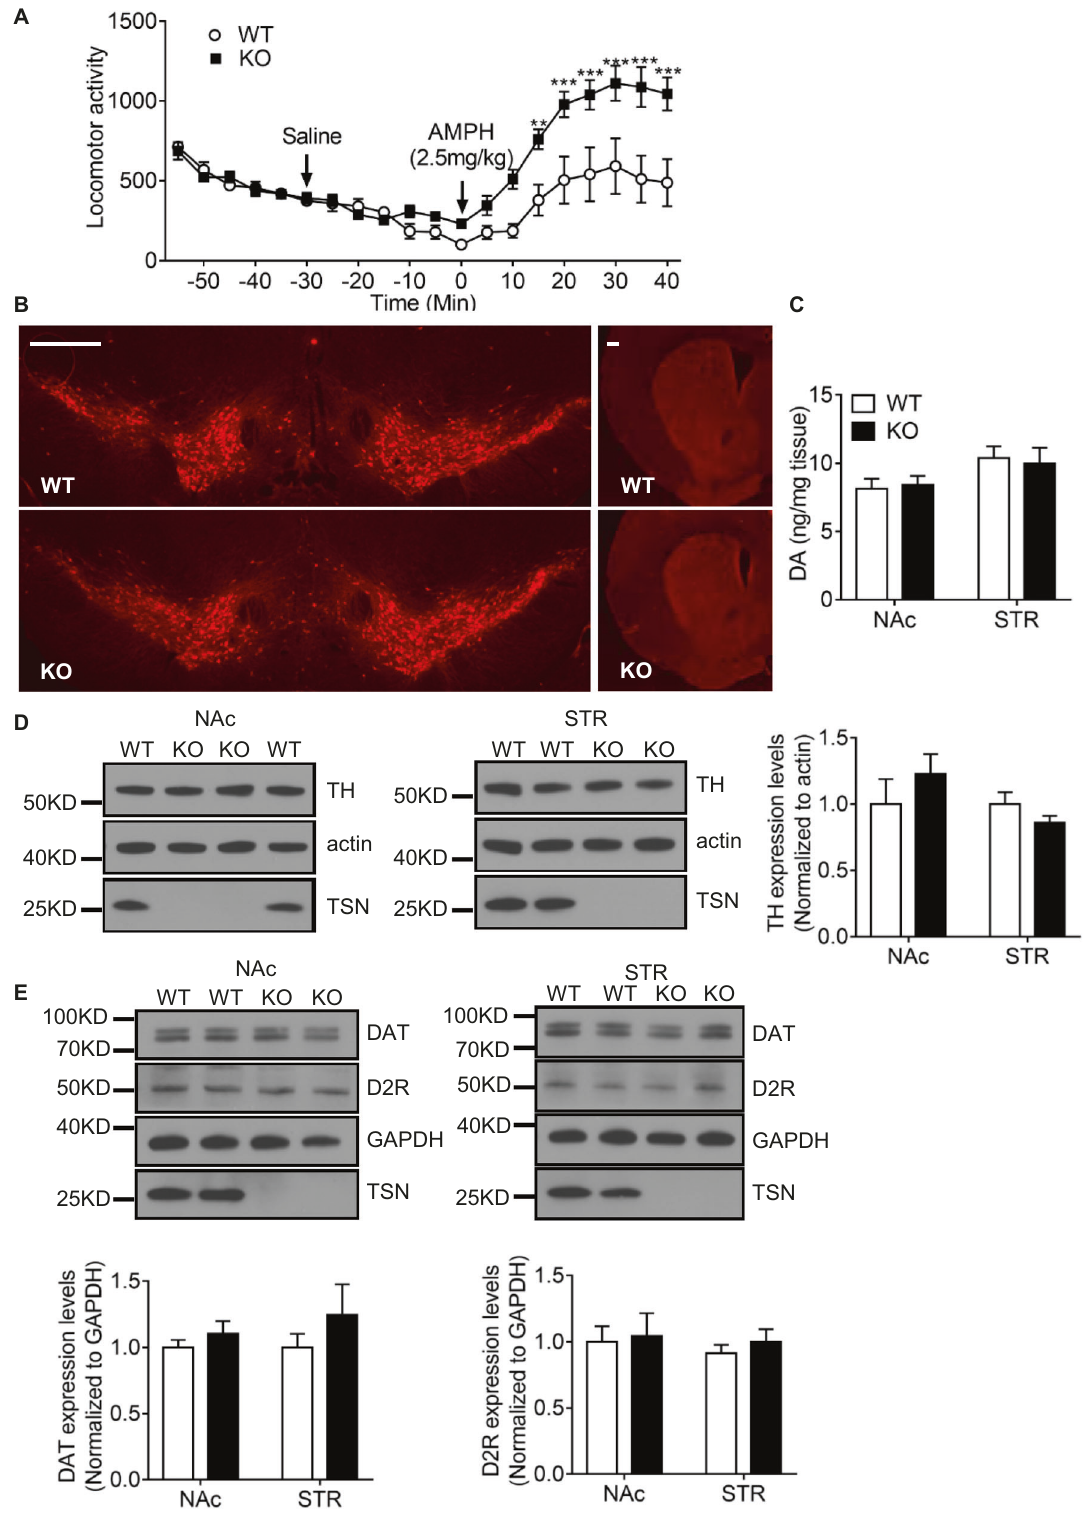
level and %body fat that is likely misleading as it appears to be driven by data from one mouse that displayed the highest amphetamine level and %body fat. In contrast, we found that brain levels of amphetamine are increased in Tsn KO mice, with a strong correlation between adiposity and amphetamine levels